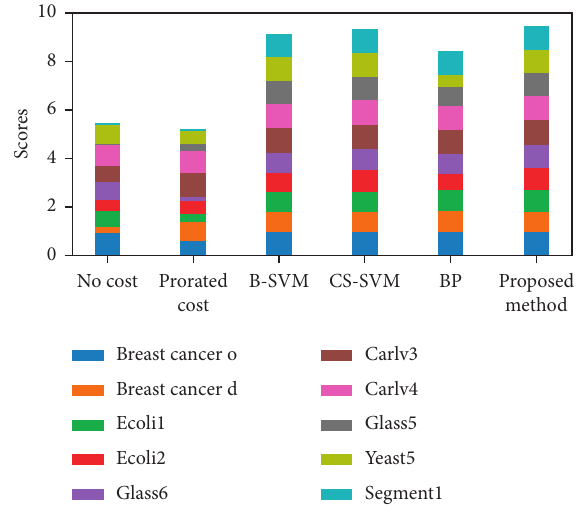
Figure 6: Comparisons of the recall ∗ g -means indices of the classification